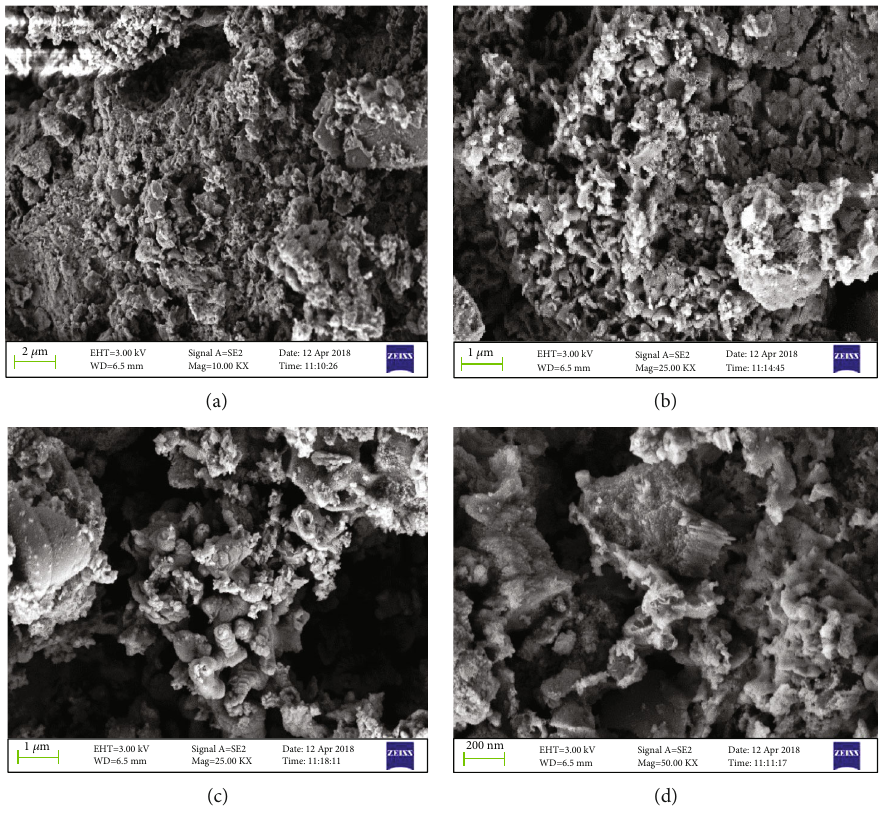
Figure 4: FESEM micrographs (a – d) of incense stick